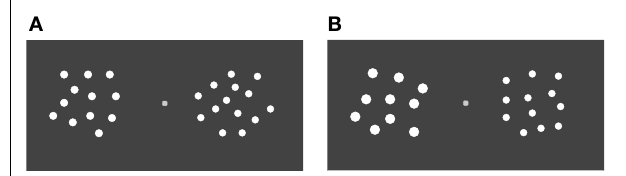
FIGURE 1 | Schematic view of stimuli in (A) the control condition and (B) the large element condition.